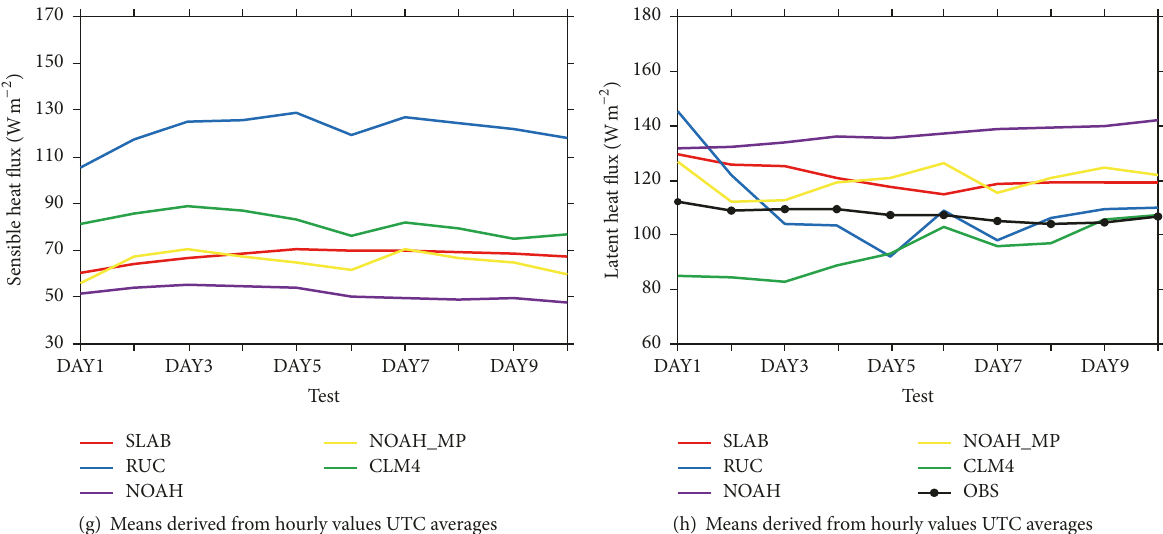
Figure 6: The simulated net energy at 06 UTC on August 10 (a), (b) the same as Figure 3(j) but for surface-soil temperature, (c) area A3- averaged DAY1 diurnal SAT variations in SHF, (d) area A3-averaged DAY1 diurnal SAT variations in LHF, (e) the same as (a) but for SHF, (f) the same as (a) but for LHF, (g) the same as (e) but from the hourly WRF outputs, (h) the same as (f) but from the hourly WRF outputs, including observation-based data from daily evaporations by Miralles et al.